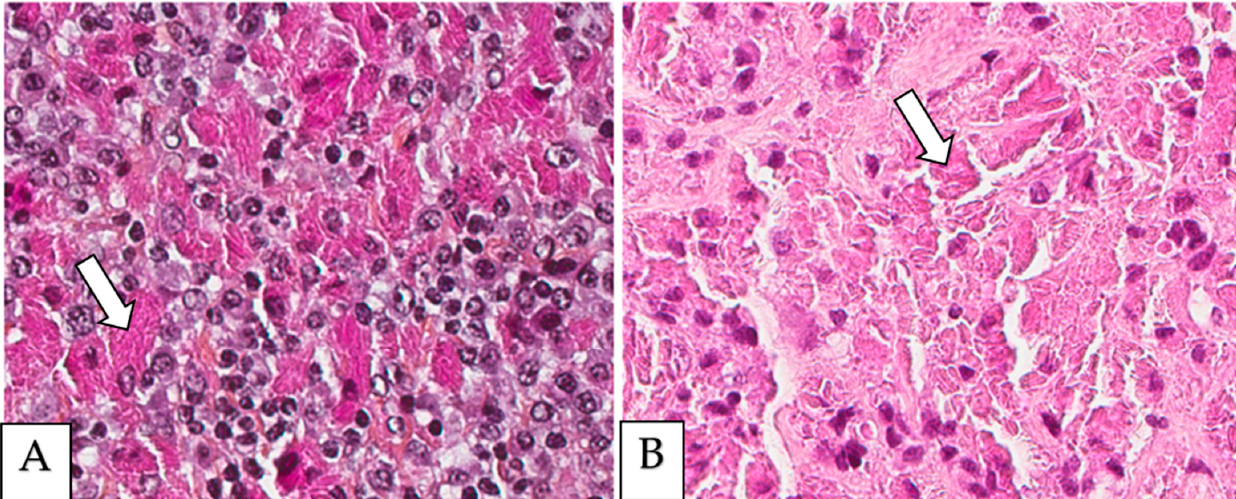
Figure 1. ( A , B ) Crystal-storing histiocytosis is characterized by an accumulation of histiocytes with intracytoplasmic crystalline inclusions (arrows). ( A , B ) High magnification of samples from two dif- ferent cases. ( A ) A 70-year-old male who presented with abdominal pain, cervical lymphadenopathy, and weight loss with colonic white mucosal elevations on endoscopy. ( B ) A 50-year-old male with a suspicious lesion of the cavum.